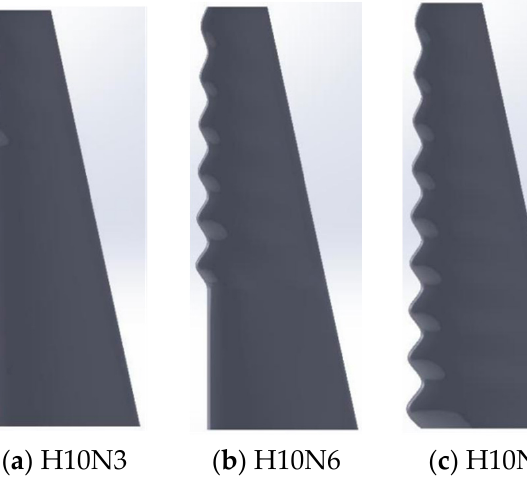
Figure 3. Illustrations of blade models with leading-edge tubercles.